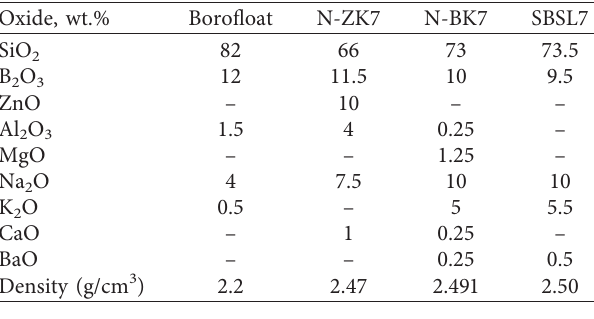
Table 4: Compositions of borosilicate glasses subjected to neutron irradiation.